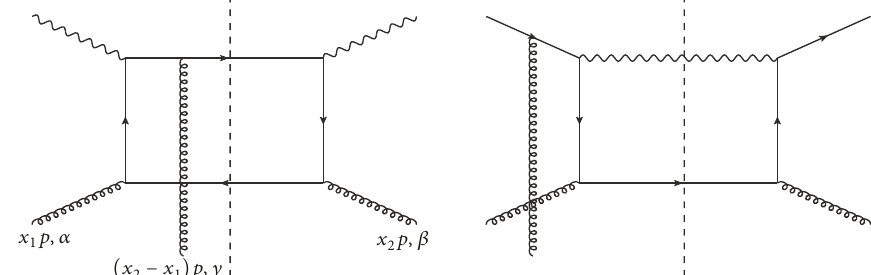
Figure 4: The diagrams which give the gluon mixing contribution to the evolution equation of 𝐺 𝑞,𝐹 (𝑥,𝑥) in SIDIS (left) and Drell-Yan